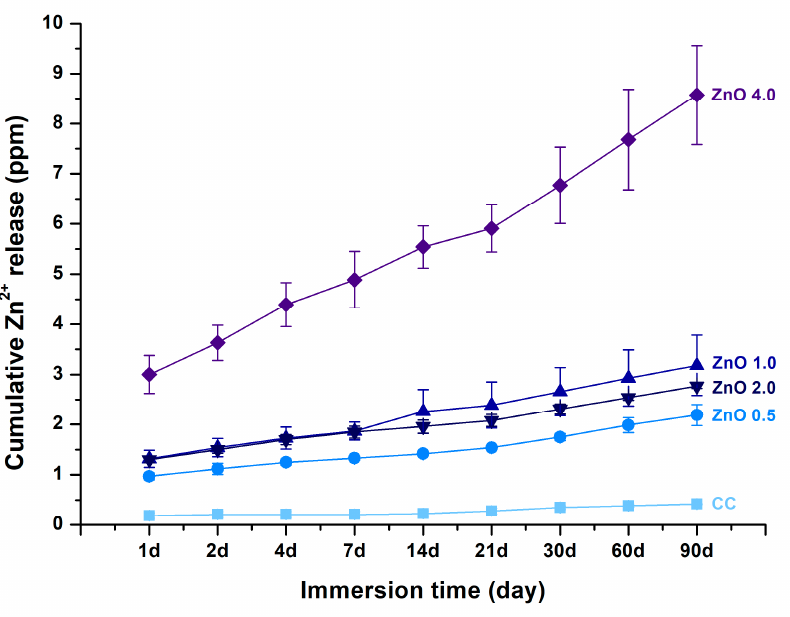
Figure 6. Cumulative Zn 2+ concentration over 90 days. The error bars indicate the standard deviation of the mean values.